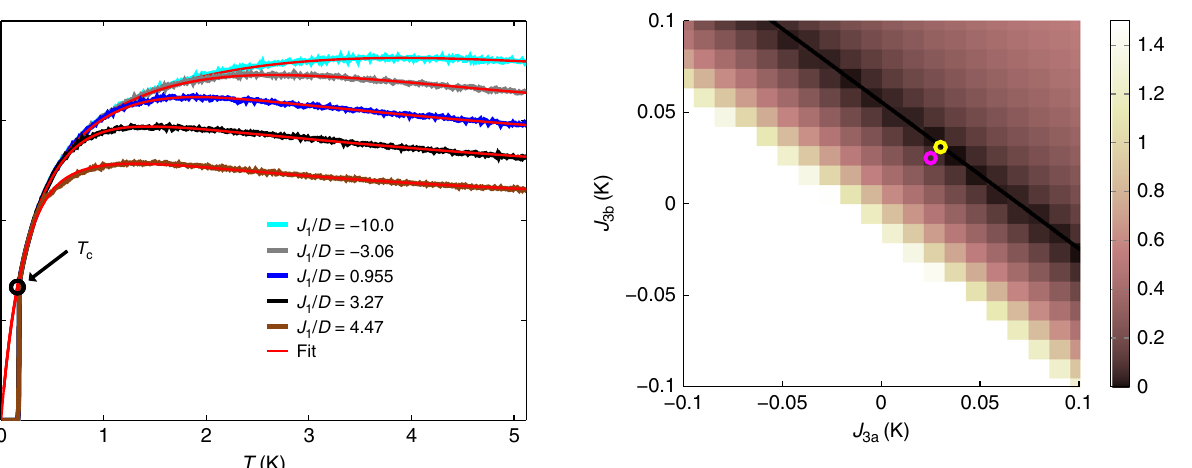
Fig. 8 Fine-tuning the third nearest-neighbour exchange interactions. χ T / C RMS-deviation of the DSM with J 1 = 3.41 K and J 2 = − 0.14 K compared to experiments. The purple ring is the g – DSM 28 and the yellow ring the g + – DSM (this work). The black line is a guide for the eye of the minimum